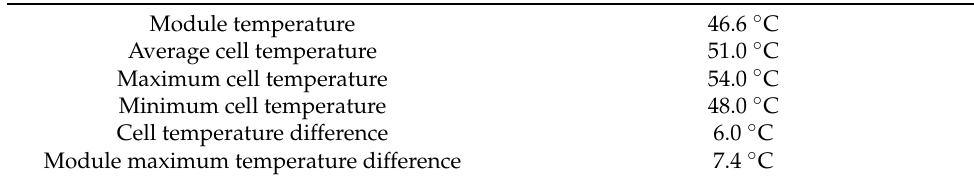
Table 4. Temperature indicators of pilot PV module